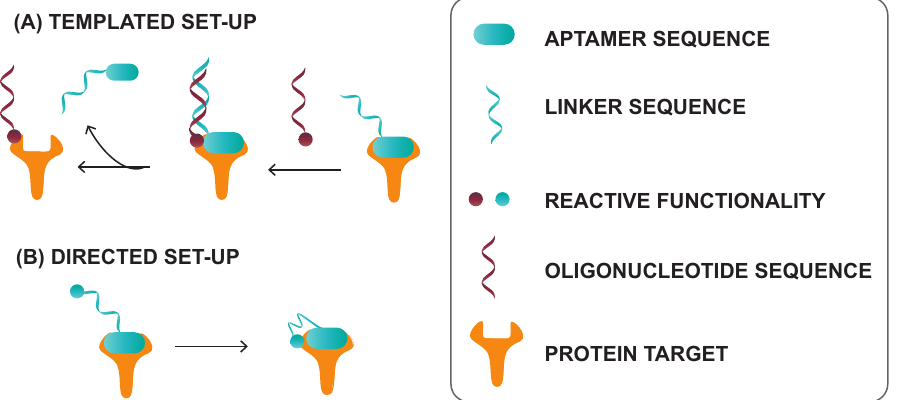
Figure 16. Principle of the templated directed ligation ( A ) and the directed non-templated ligation strategy ( B ). Reprinted (adapted) with permission from Chem. Sci., 2016, 7,